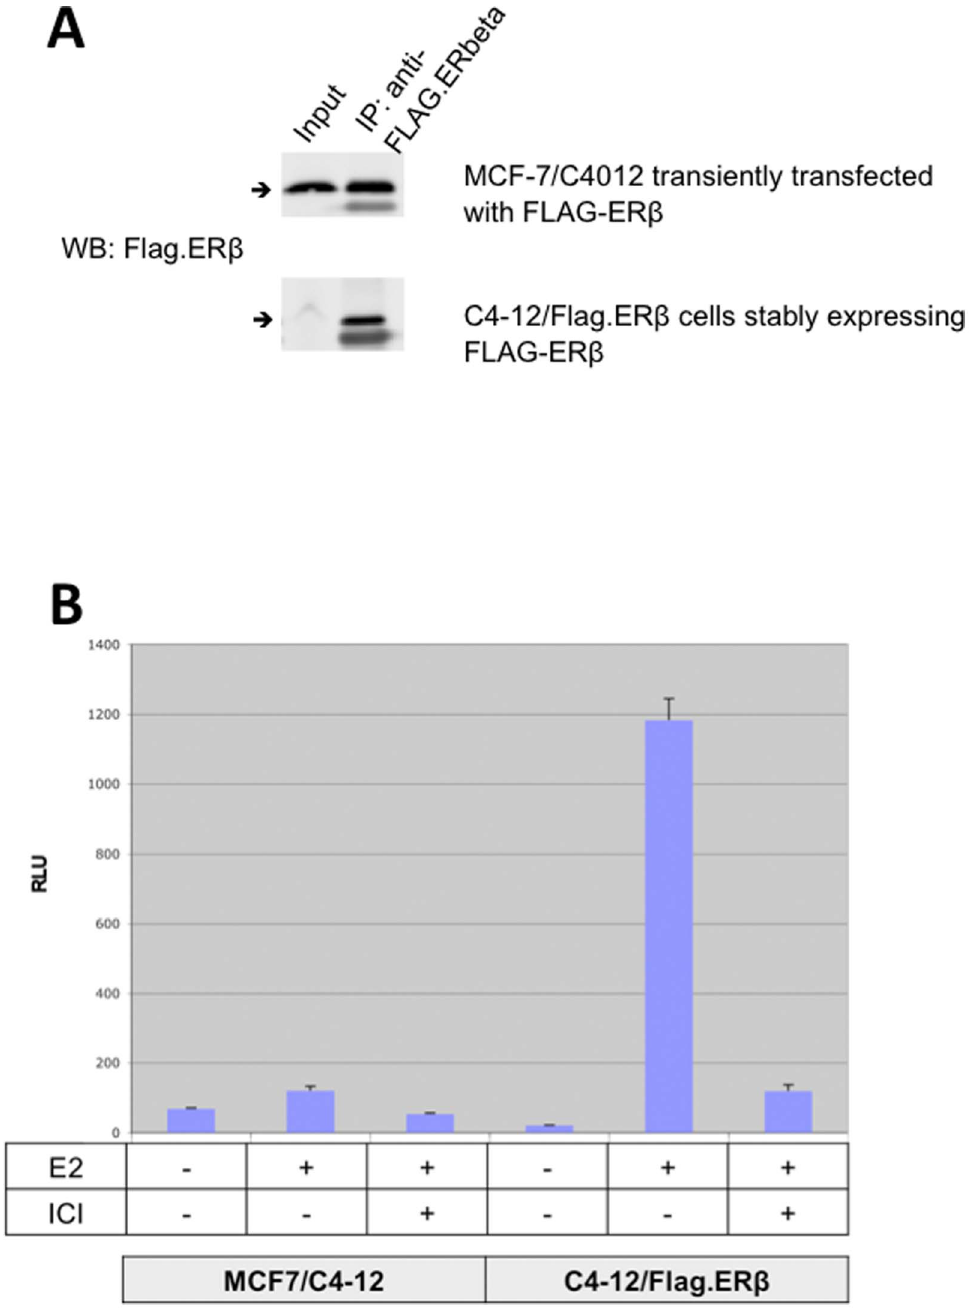
Figure 1. Validation of the C4–12/Flag.ER b cell line. A – Flag.ER b stably expressed in C4–12/Flag.ER b cells was detected (because of low expression level, the ER b band in the input lane was faint) and immunoprecipitated with anti-Flag antibody. Lysates of MCF-7/C4–12 cells transiently expressing Flag.ER b were used as positive controls. B – Luciferase reporter assays confirmed the expression of a functional ER b in C4–12/Flag. ER b cells. C4–12/Flag.ER b cells were cultured in 48-well plates, then transfected with 3xERE-Luc and RTK plasmids. After 24 hours of treatment with 10 nM E2 or Vehicle (Ethanol), cells were lysed with Passive Lysis Buffer (Promega) and processed with Dual Luciferase Assay (Promega). (RLU=relative light units; error bars=standard deviation).